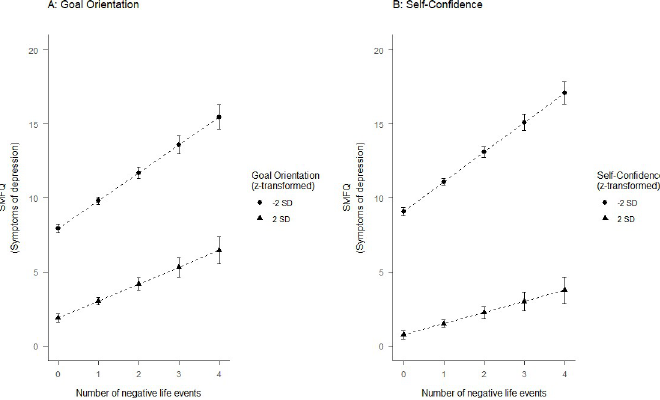
Fig 2. The association between negative life events and symptoms of depression for adolescents with (A) Goal Orientation and (B) Self-Confidence scores ± 2 standard deviations from the mean score. SMFQ: short moods and feelings questionnaire, SD: standard deviation. Error bars represent 95% confidence intervals.